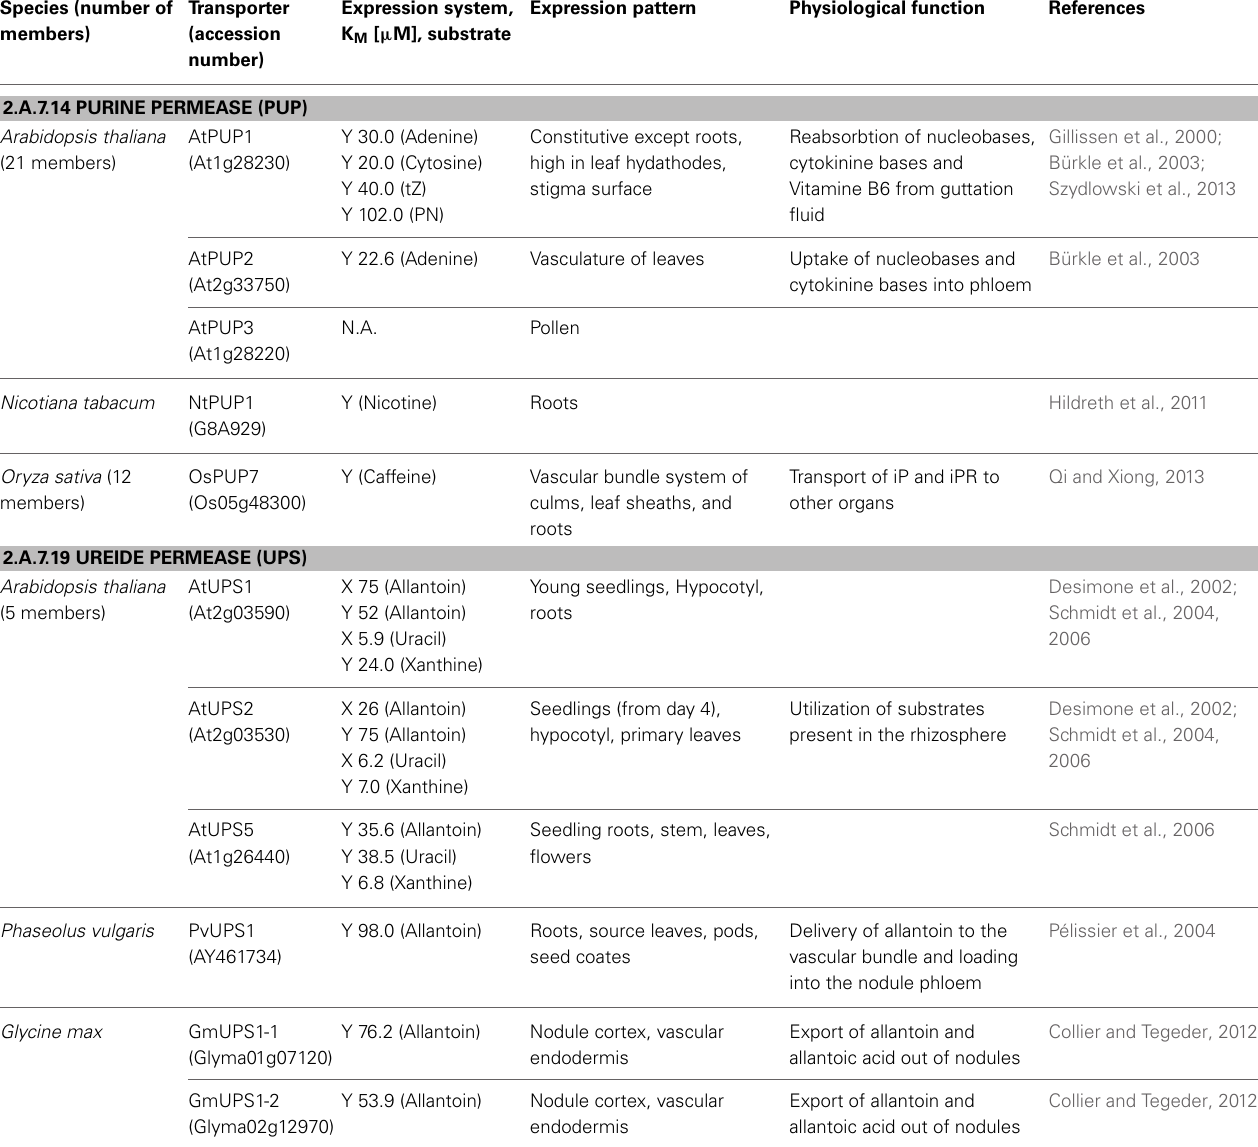
Table 2 | Nucleobase transporters of the PUP and UPS families. Species (number